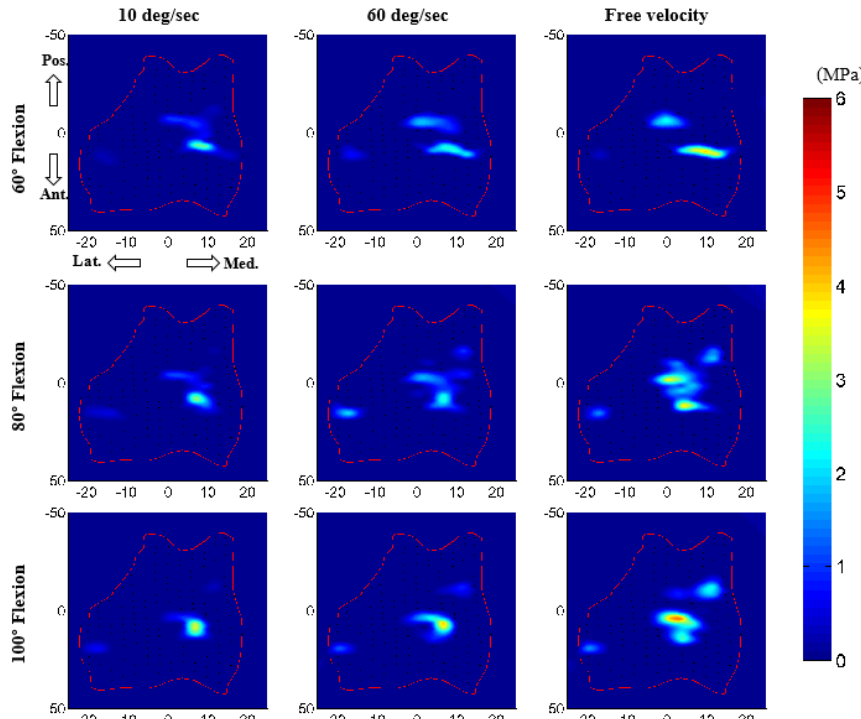
Figure 8. Contact pressure distribution on humeral cartilage for muscle-driven forward dynamic simulation. x- and y -axes units are in mm and the intensity of colour represents the intensity of contact pressure. The red boundary represents the unfolded 2D projection of the humerus cartilage.